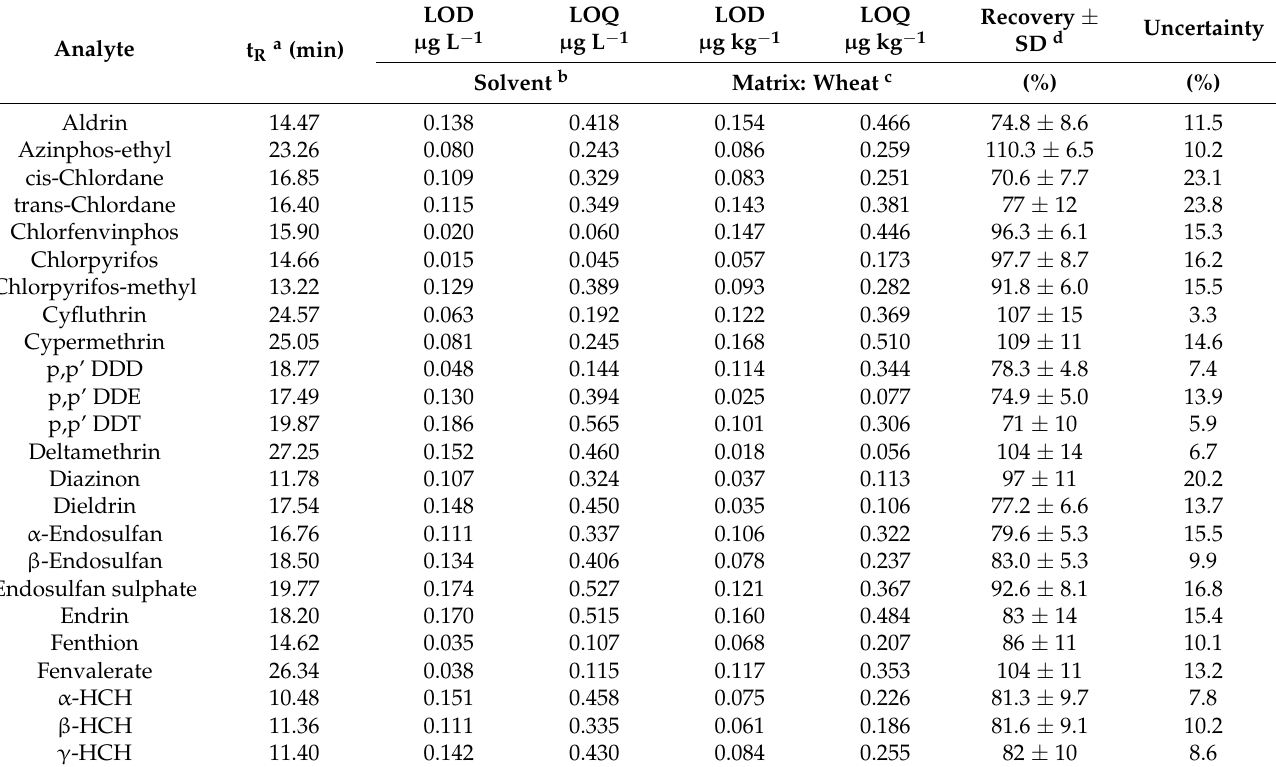
Table 2. Performance and chromatographic parameters of pesticides analyzed by